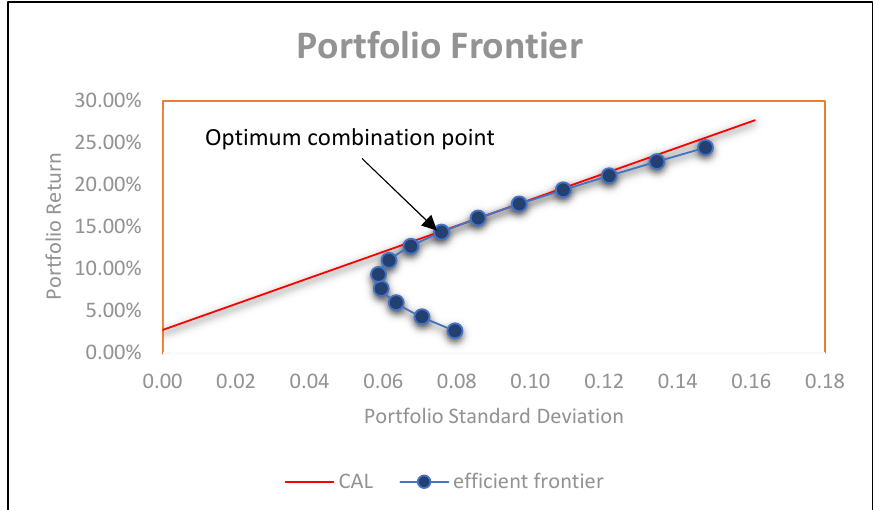
Figure 1. Portfolio frontier for a two-asset portfolio.